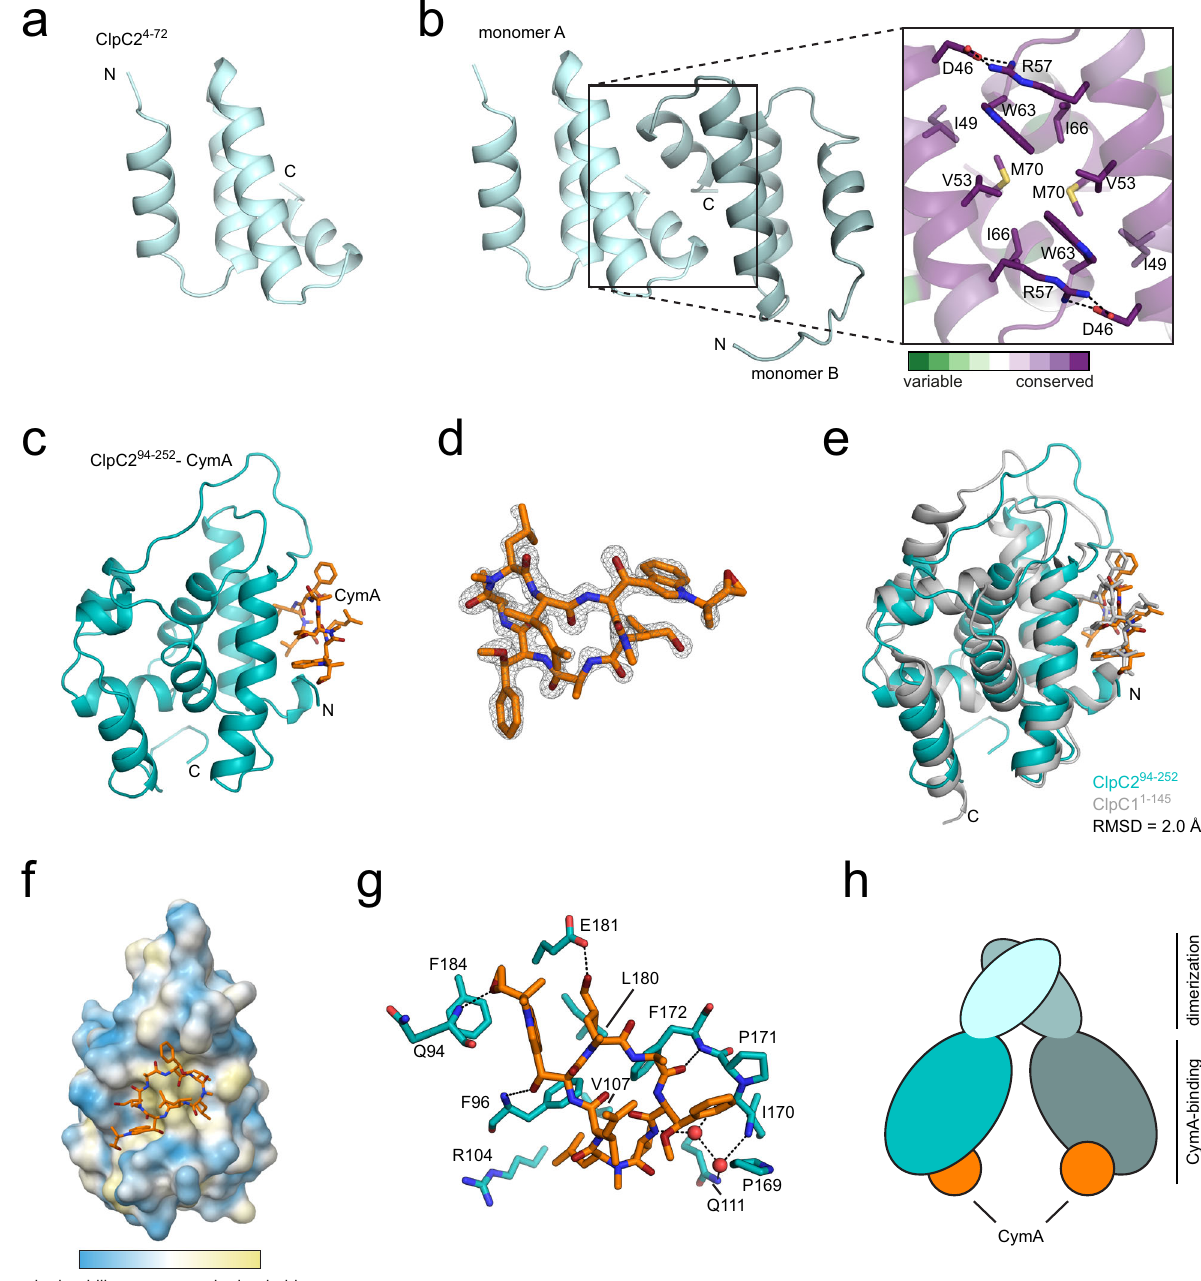
Fig. 2 Crystal structure of the ClpC2 N-terminal domain and of the ClpC2 C-terminal domain in complex with CymA. a Crystal structure of the N-terminal domain of ClpC2 (ClpC2 4 – 72 ). b ClpC2 4 – 72 forms a homodimer in the crystallographic asymmetric unit (left panel) with each monomer coloured in light blue or light teal. In the right panel is a close-up view of the dimeric interface between ClpC2 monomers coloured according to the conservation of residues. Dashed lines suggest electrostatic interactions. c Overall structure of ClpC2 C-terminal domain (ClpC2 94 – 252 ; cyan) bound to CymA (orange). d The unbiased mF o -DF c Fourier map of CymA at 3.0 σ was calculated following molecular replacement using PDB 3WDC as a search model excluding ligands. e ClpC2 94 – 252 (cyan) bound to CymA (orange) is superimposed onto ClpC1 NTD bound to CymA (PDB 3WDC; grey) showing a root mean square deviation (RMSD) of 2.0 Å. f CymA (orange, stick representation) bound to ClpC2 94 – 252 (surface representation), coloured according to hydrophobicity. g Detailed molecular interactions between CymA and ClpC2 C-terminal domain. Shown in stick representation are the residues of ClpC2 (cyan) that are in close proximity to CymA (orange) with suggested hydrogen bond interactions represented by dashed lines and water molecules represented as red spheres. h A cartoon model of ClpC2 dimer colour-coded according to the presented ClpC2 crystal